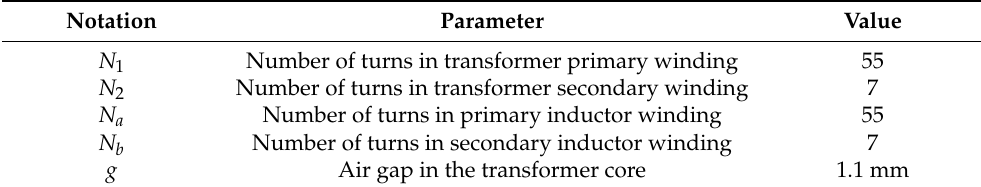
Table 6. Converter design